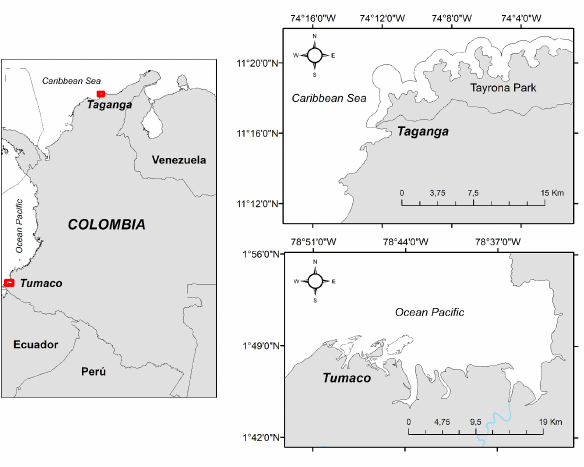
Fig. 1. Maps of the study area, showing the community of Taganga on the Caribbean coast and the community of Tumaco on the Colombian Pacific